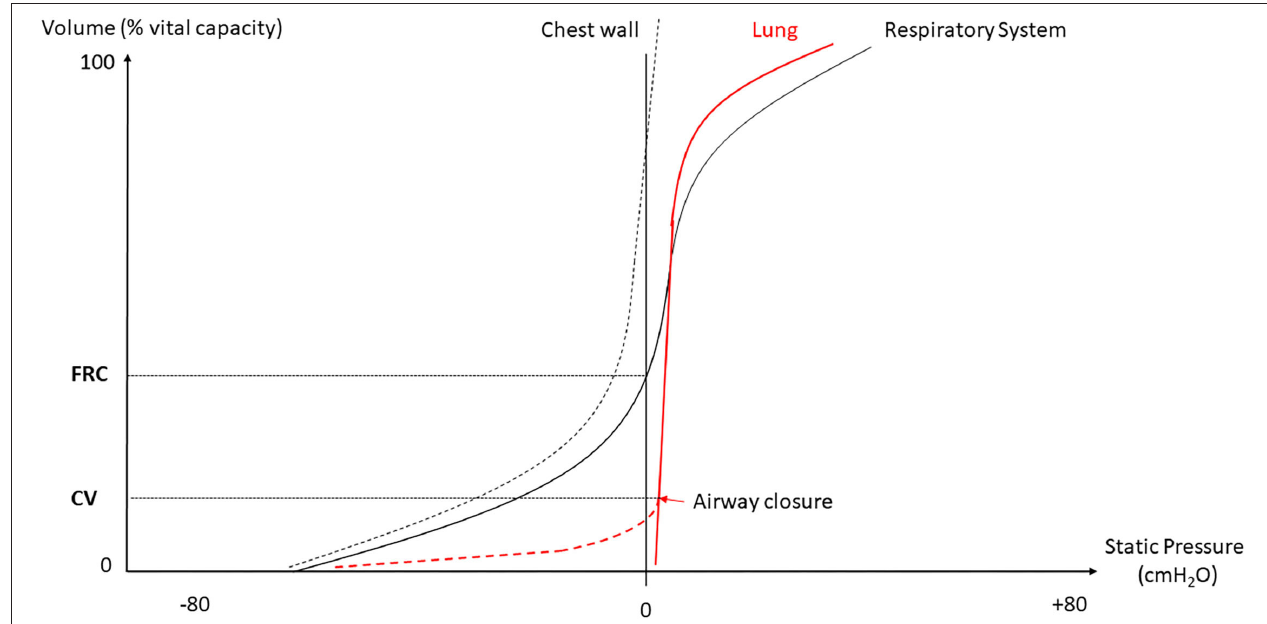
FIGURE 1 | Deflation static volume-pressure (VP) curve of the lung, chest wall and whole respiratory system. FRC, functional residual capacity; CV, closing volume.